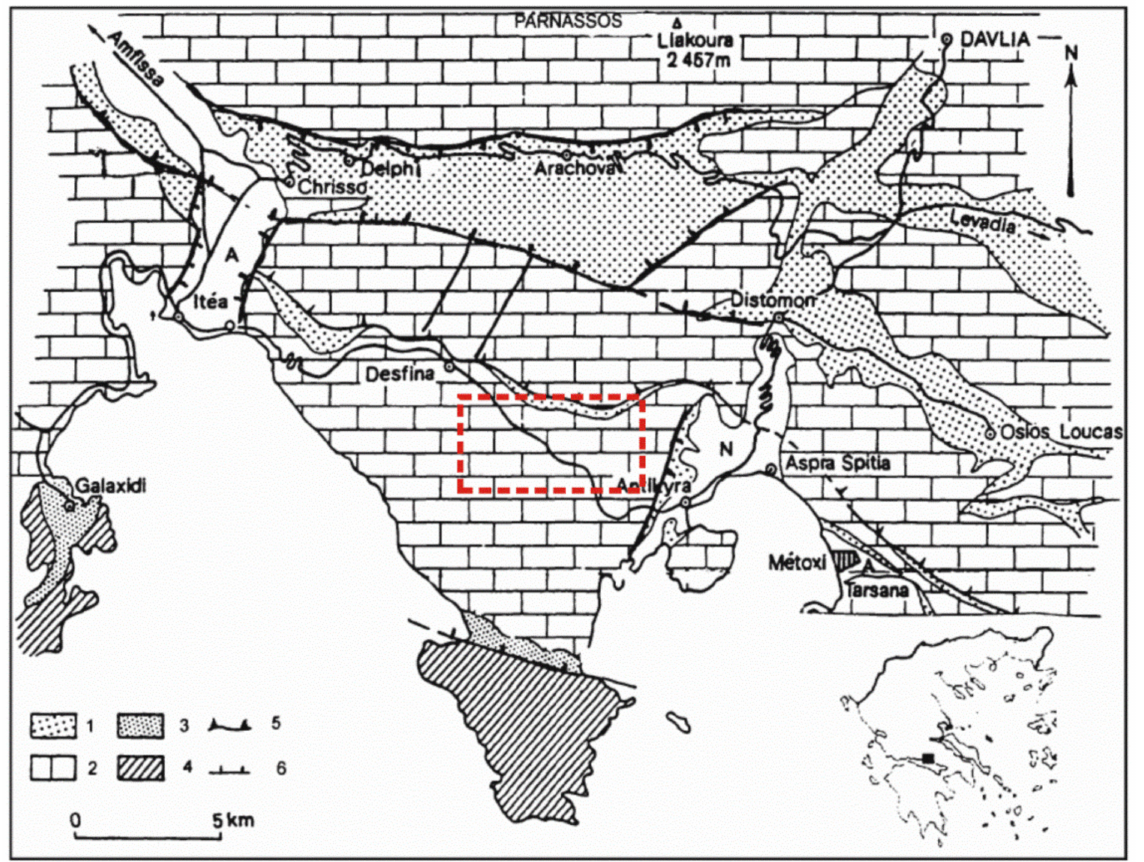
Figure 2. Simplified geological map of the studied area (by Marinos; modified by Celet) [19,20]. Parnassus-Ghiona zone: 1. Flysch; 2. Limestones; Pindos Zone: 3. Flysch; 4. Limestones and cherts; 5. Overthrust; 6. Fault. The red dashed framework outlines the studied